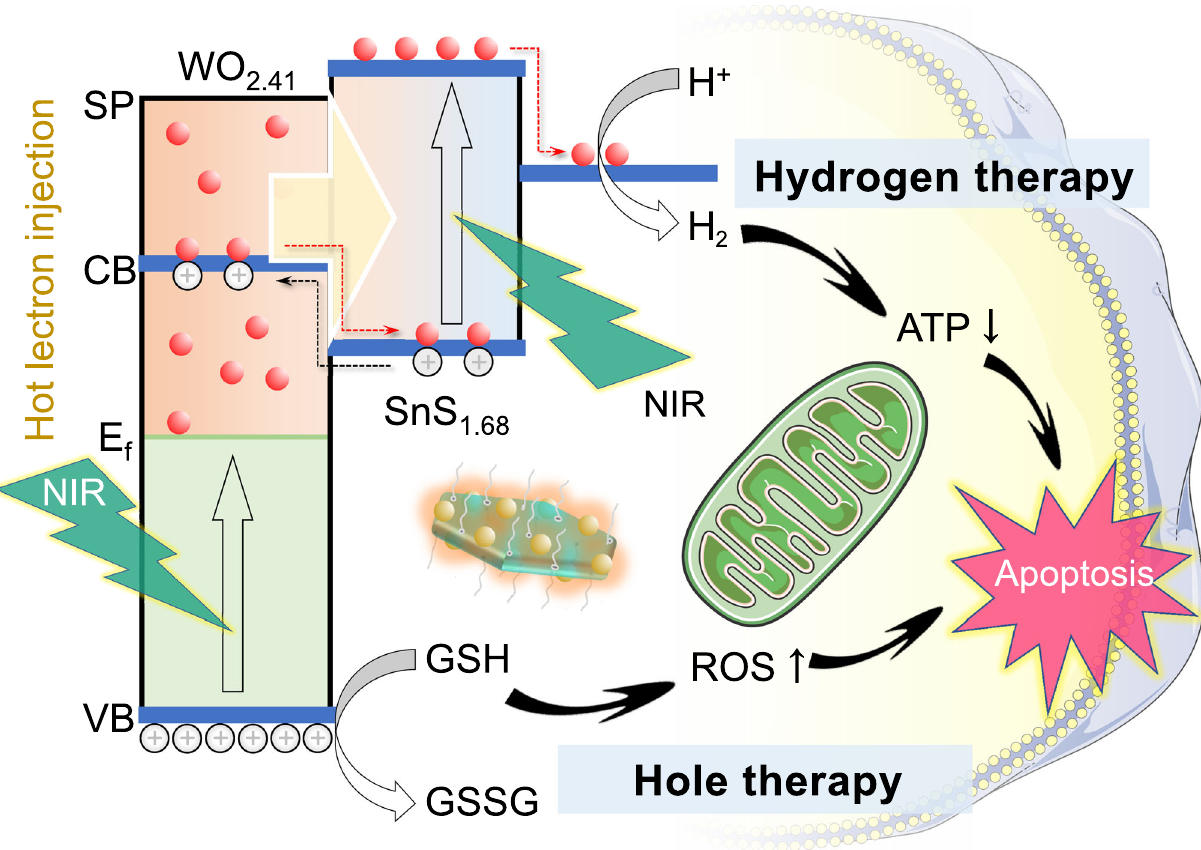
Fig. 1 Schematic illustration of combined hole/hydrogen therapy strategy and mechanisms with the NIR-activable Z-scheme SnS 1.68 – WO 2.41 nanocatalyst. Several main advances are achieved. (1) Advanced strategy of photocatalysis-mediated drug-free therapeutics is proposed. (2) Advanced Z-scheme SnS 1.68 – WO 2.41 nanocatalyst is facilely constructed to achieve NIR-triggered ef fi cient generation of highly oxidative holes and hydrogen molecules. (3) Advanced concept and mechanisms for combined hole/hydrogen therapy are proposed and uncovered. (4) Advanced therapeutic performances with drug-free and controllable generation of hydrogen and consumption of intratumoral over-expressed GSH are achieved by the nanocatalyst, realizing high biosafety and high ef fi cacy of drug-free